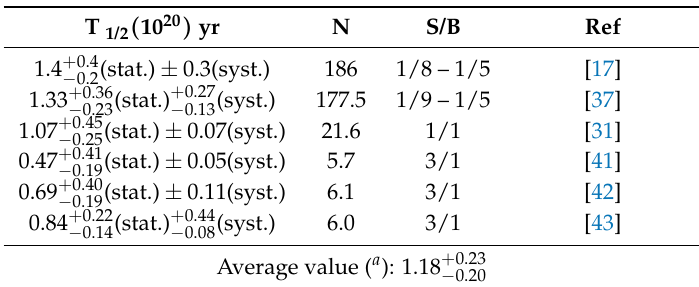
Table 3. Half-life values of the 2 β − decay of 150 Nd to the 0 + far by different experiments. N is the number of detected events or coincidences and S/B is the signal/background